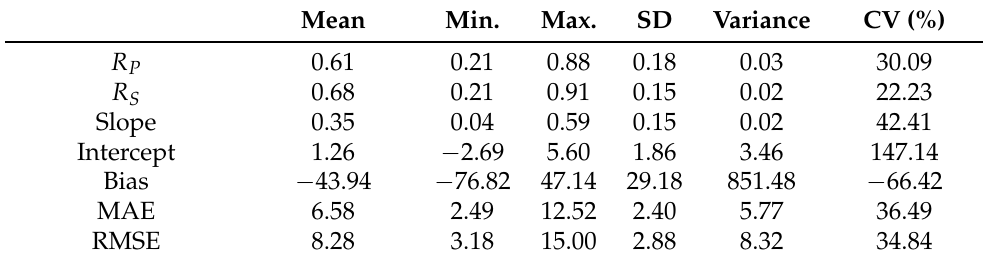
Table 9. Analysis of statistical metrics across all 21 pilot data sets.